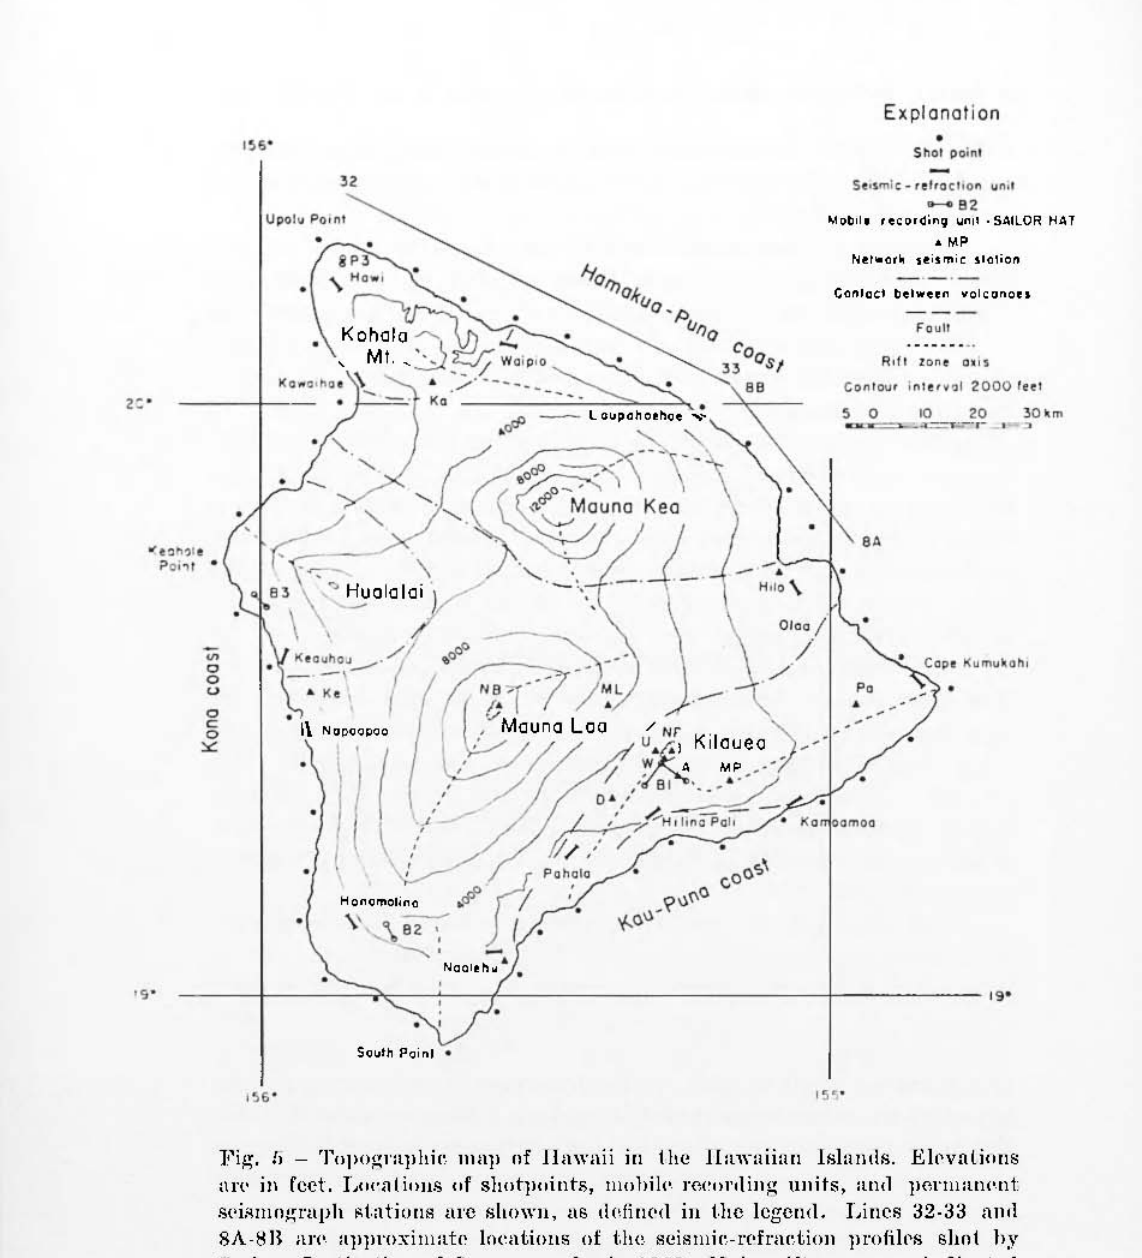
Fig. il - ']'opogmphie map of Hawaii il! [he llawaiiall lslaIHls. Elt'vuliolls an' in fcct. L,,,,<lfiolls of shot]loints, mollilp. ]"c('o]',!ing ll11its, IltHl pCl"mlltwnt s{'i.~!llngrajJh ~j.atioIlH are ShOWlI, aB ,1(>lil1('\\ ili t.he lcgC!HI. Lillcs 32·33 all,l 8A-I:!B an', ilpproximate loeatiollS of ti\(' scisIllie-rl'fradioll pro/H!'!; sllol by ~cl"ijJjJ~ Jllslitllti"ll or OCCflllOgrUl'hy in 1!lti2. ~laim l'ift, WtH'S are itHlieatp,j h.v short (la8hl'<\ liu('s. 'l'he Eu!'!; or allcmatiug (lols alul (Jnshcs separate t.1U' li,,('. voleallocs aeconlillg to Hurfm'c geology. Al,l,!"pviatiol\iI fo]' spiSlllog"l'aph stat.ion l,watinnH a]'p; A, Ahua; D, Ih'serl; Ka, Kanl1lpla; Ke, 1\cala1\cl,ll<1; MI., Mfl1Ina j.na; MP, ~lakanl'lIhi; NB. X"rlh Ba,)'; NP. Xorth l'it; Pa, l'ah"lI; U, lJwcl,ahllllfl; W, \\'l's1; Pit [[rolll llill